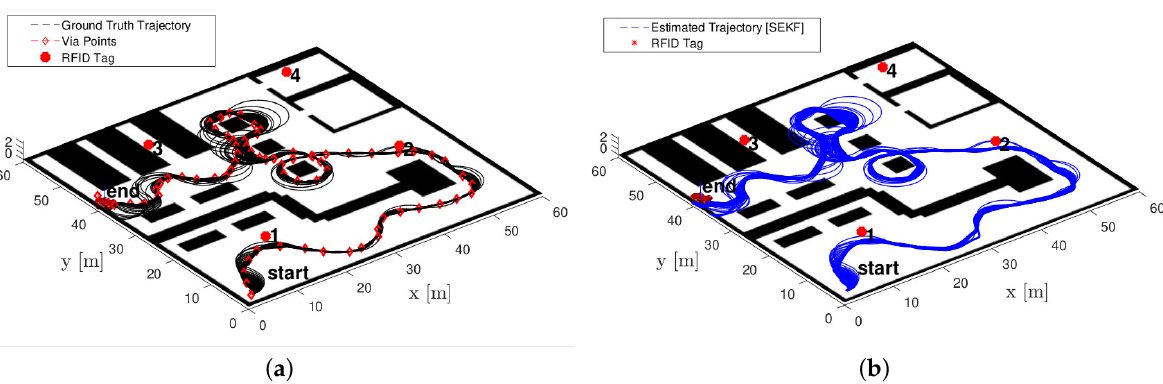
Figure 4. Trajectory samples generated by different velocities for the same path in a realistic warehouse scenario. ( a ) Ground truth trajectories, ( b ) estimated trajectories by the SEKF. A possible configuration of the four RFID is reported with red circle markers and denoted with